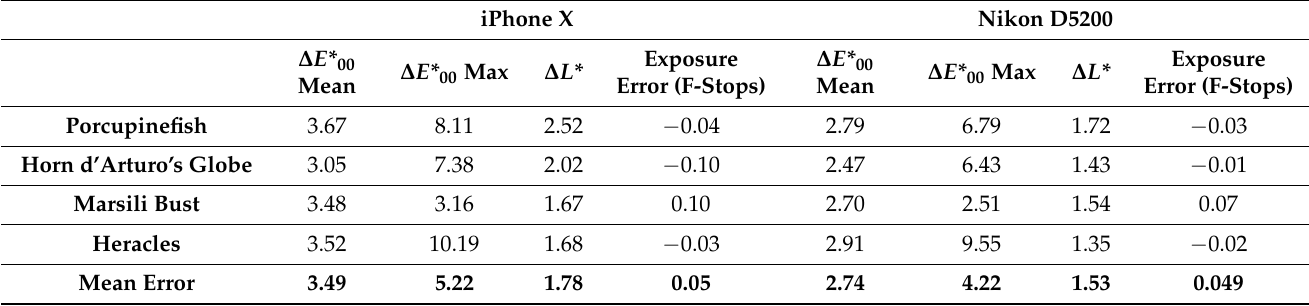
Table 6. Apple iPhone X vs. Nikon D5200– ∆ E* 00 evaluation.